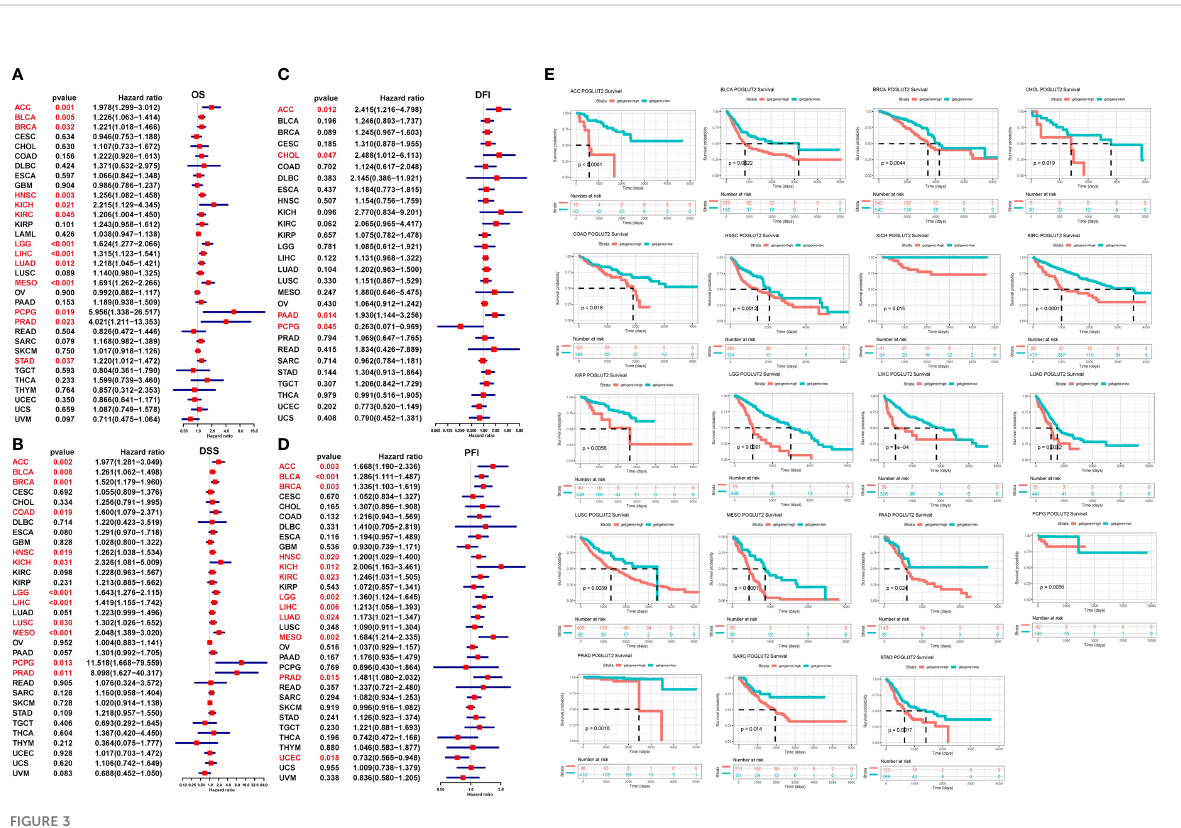
FIGURE 3 The impact of POGLUT2 on survival of pan-cancer by univariate logistic regression and receiver operating characteristic (ROC) curves. Red characters represent the data of signi fi cance. (A) Overall survival (OS). (B) Disease-speci fi c survival (DSS). (C) Disease-free interval (DFI). (D) Progression-free interval (PFI). (E) ROC curve for survival in pan-cancer classi fi ed by high and low expression of